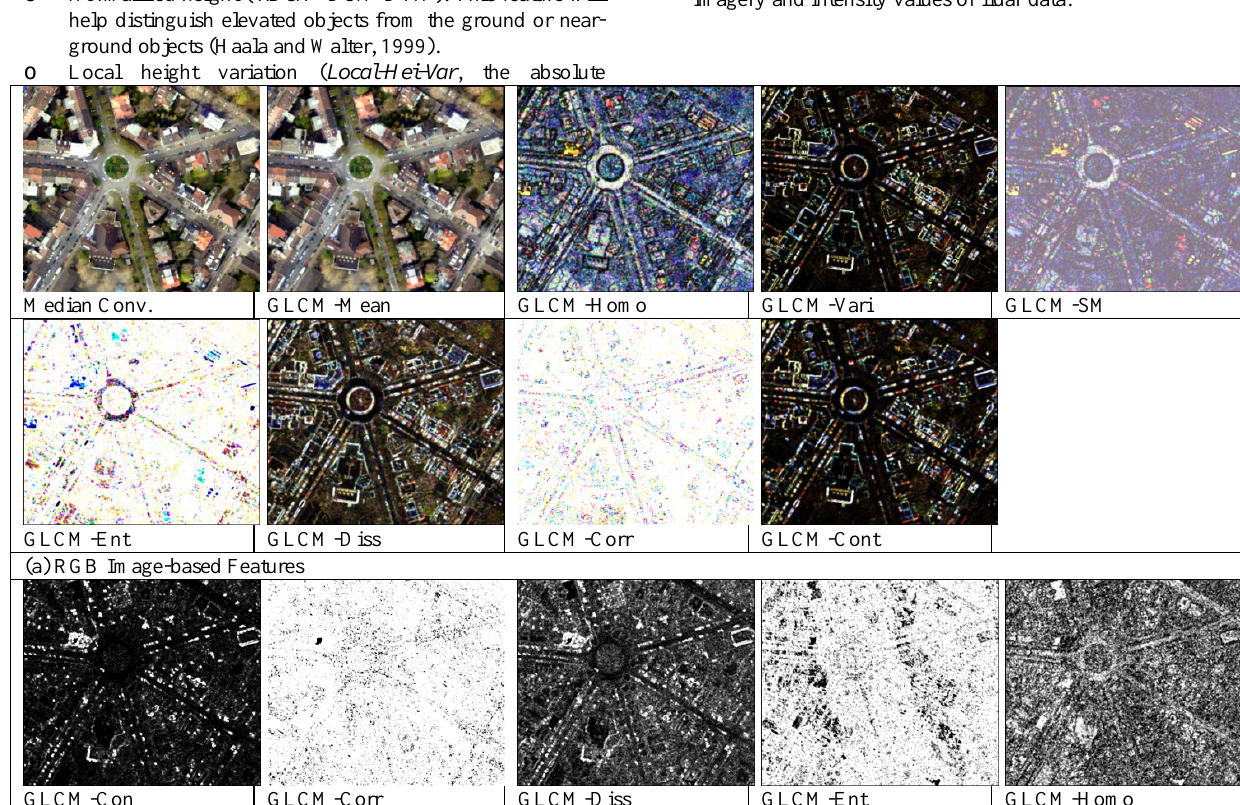
Aerial Imagery-based (Figure 2(a)): Three bands (R, G, B): To remove noises in the RGB image, convolution operation must be operated. In this paper, we use median convolution, a technique aiming at reducing image noise without removing significant parts of the image content, typically edges, lines or other details that are important for the interpretation of the image (Perona and Malik, 1990). After mean convolution, bands red (R), green (G) and blue (B) are used as three individual spectral features.